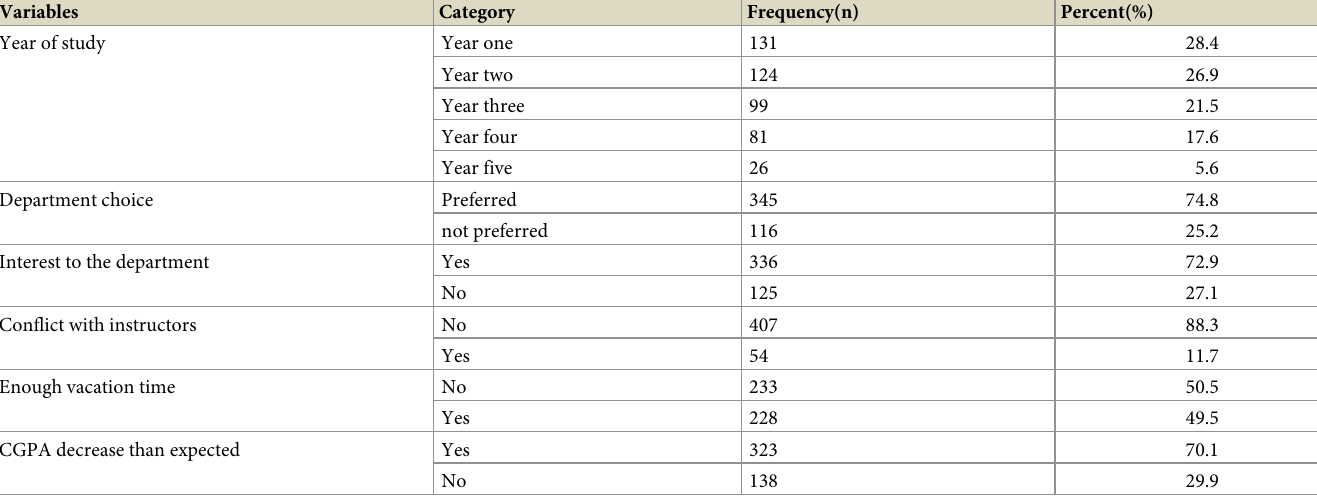
Table 2. Academic related characteristics of DMU SMCHS students on mental distress, North West, Ethiopia, 2021(N = 461).